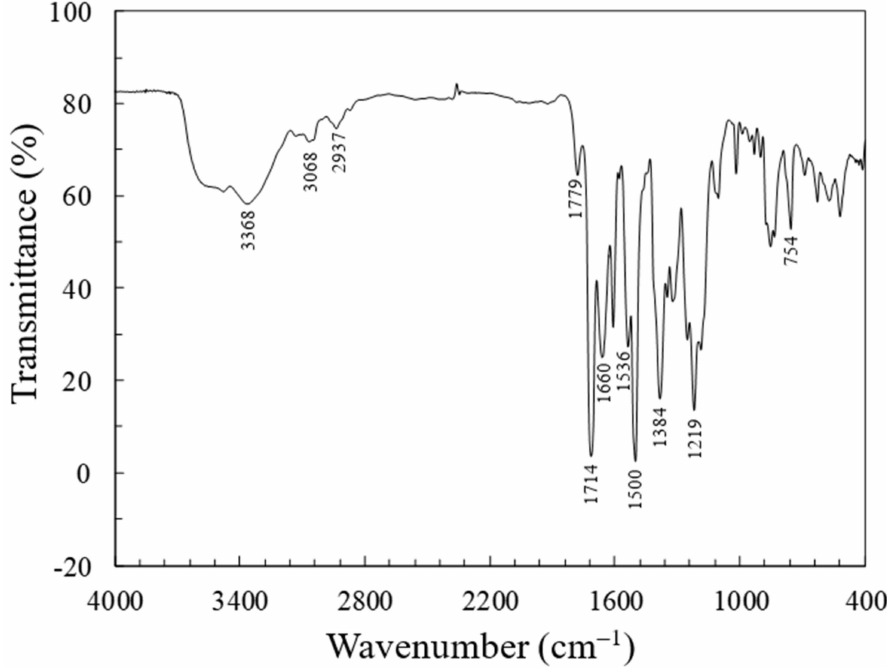
Figure 6. FT-IR spectrum of a thin cast film for H-PMDA/AB-44ODA polyimide prepared via the modified one-pot